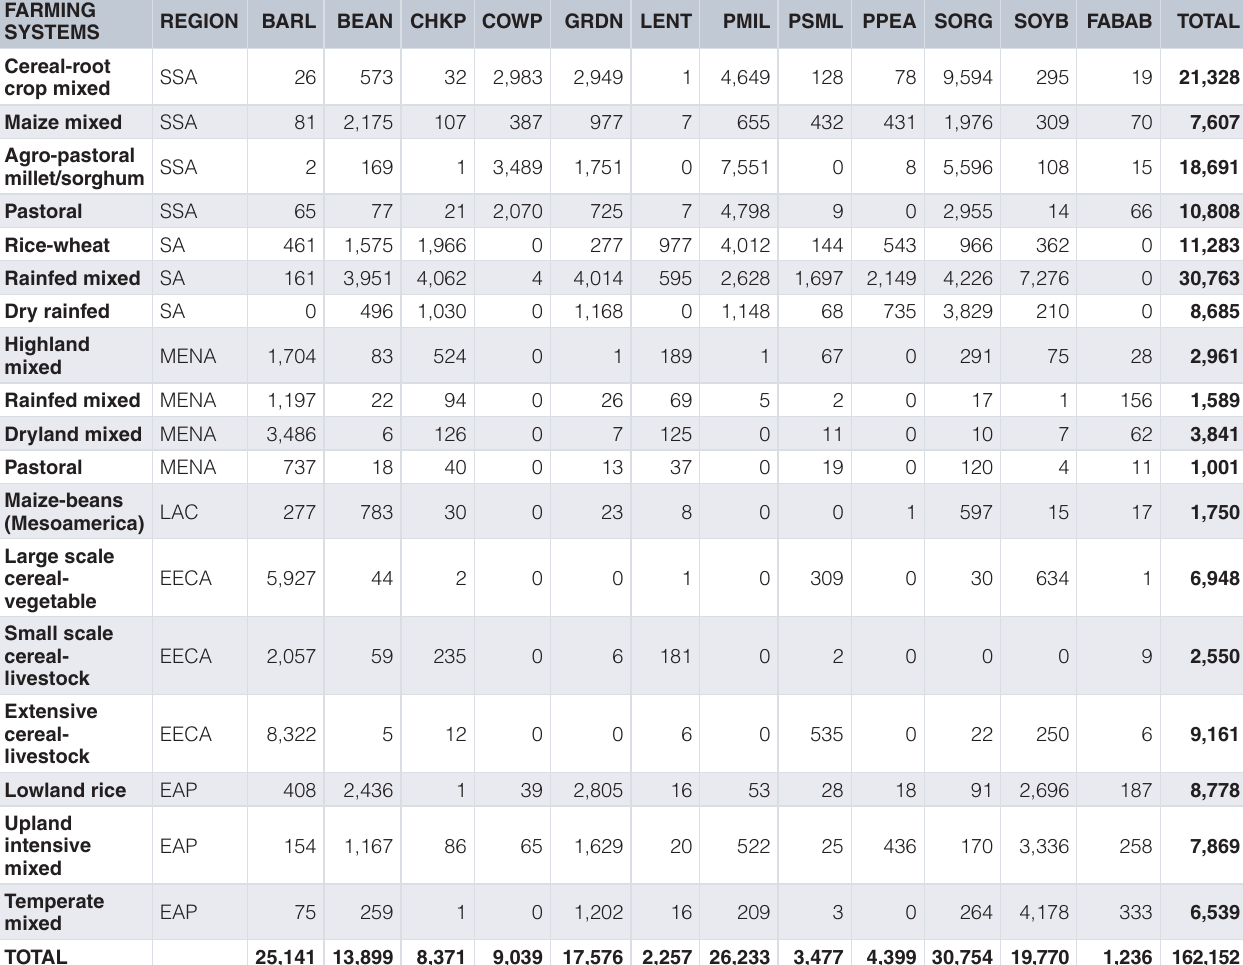
Table 1. DCL crop area in ‘000’s of hectares in 18 priority farming systems worldwide. FARMING